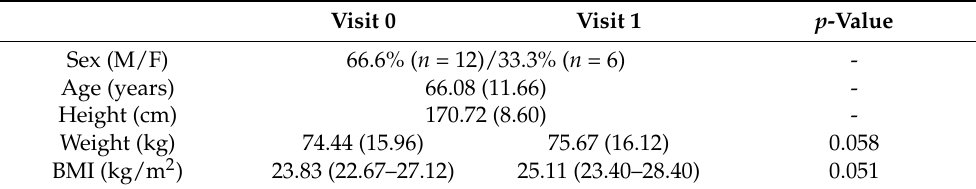
Table 1. Anthropometric parameters at the baseline visit and after a 3-month sodium bicarbonate administration in non-dialysed chronic kidney disease (CKD) 3–5 stages